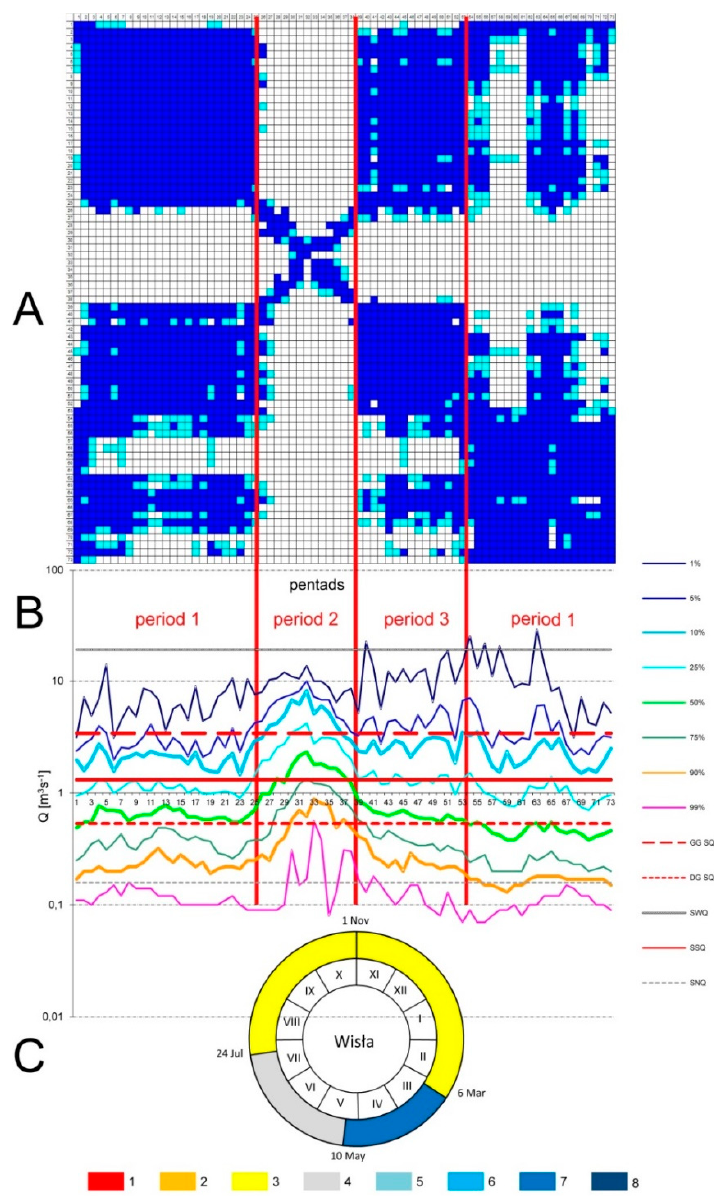
Figure 2. ( A )—Diagram of a similarity matrix for an annual set of pentads with the distinguished types of hydrological periods of the Vistula River in gauge Wisła: navy blue dot—similar distribution of discharges, blue dot—probably similar distribution of discharges. ( B )—hydrogram of water discharges of specified probability of occurrence, with characteristic discharge and boundaries of average discharge zone: SWQ—average high discharge; SSQ—average medium discharge, SNQ—average low discharge; GGSQ—upper boundary of average discharge zone; DGSQ—lower boundary of average discharge zone. ( C )—sequence of hydrological periods in average annual cycle. Types of hydrological